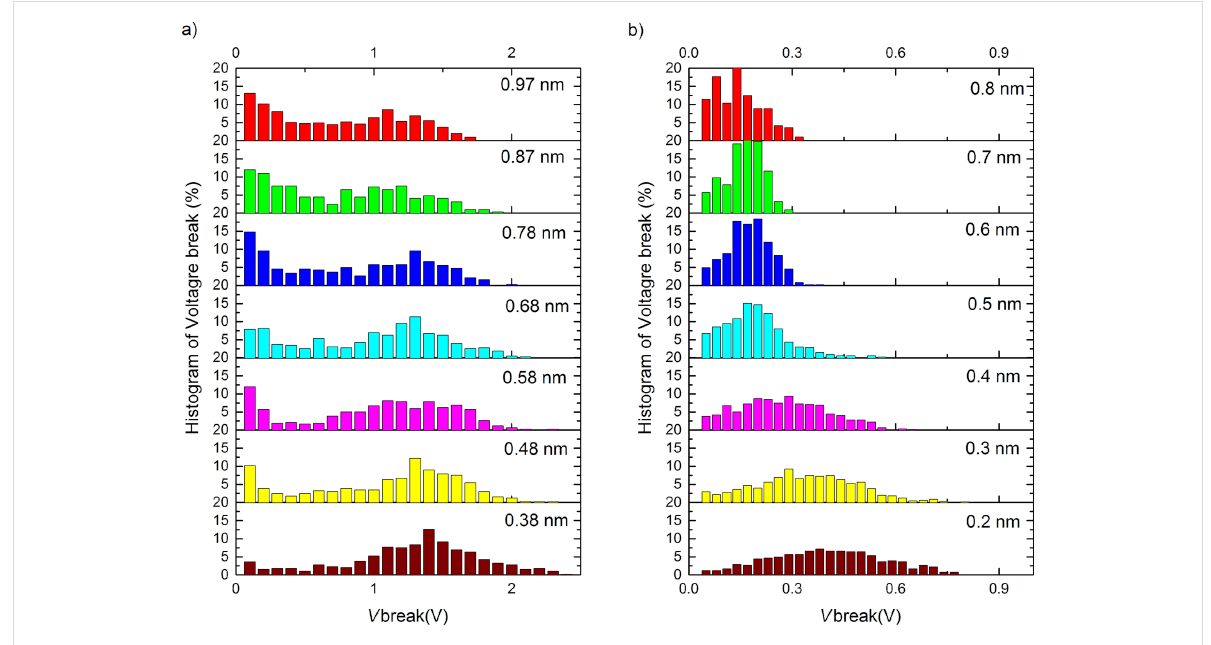
Figure 4: (a) Histogram of break voltage, V b , for Au atomic chains of lengths between 0.38 and 0.97 nm, as indicated in each of the panels. The results are shown as the percentage of all observed current-induced breaks. (b) Histogram of break voltage, V b , for Pt atomic chains of lengths between 0.2 and 0.8